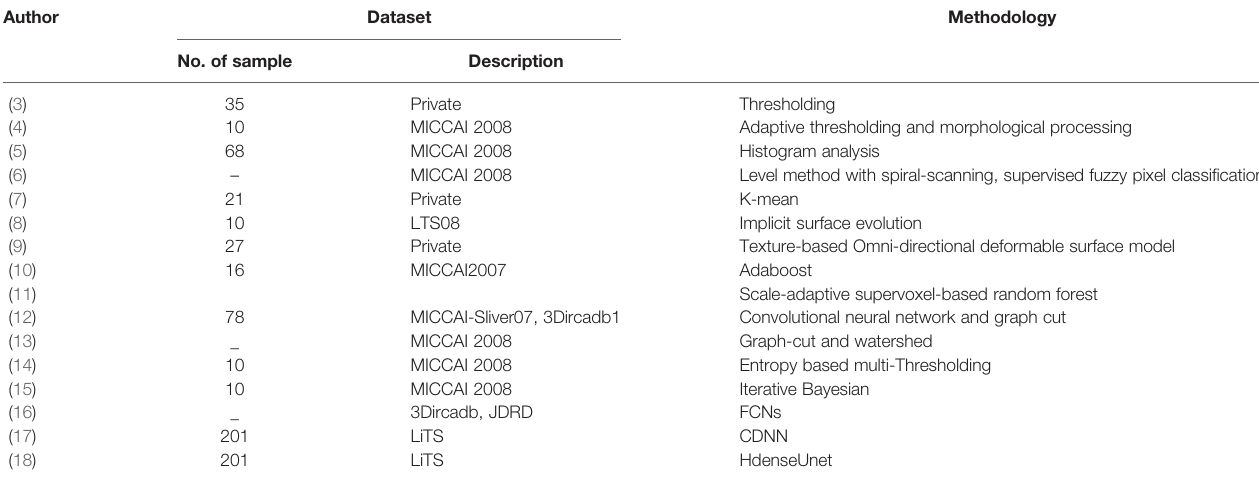
TABLE 1 | Liver tumor segmentation